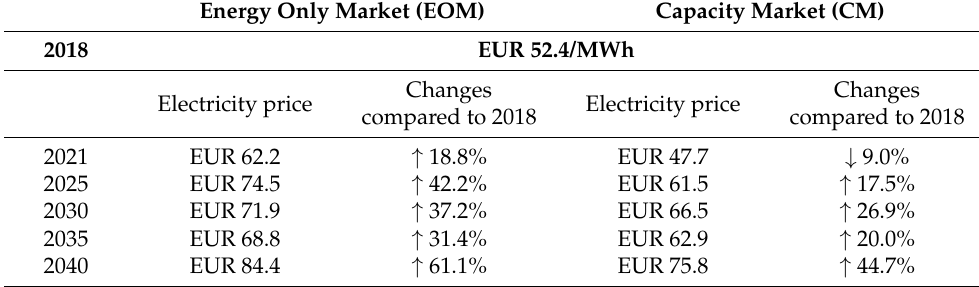
Table 10. Average annual electricity